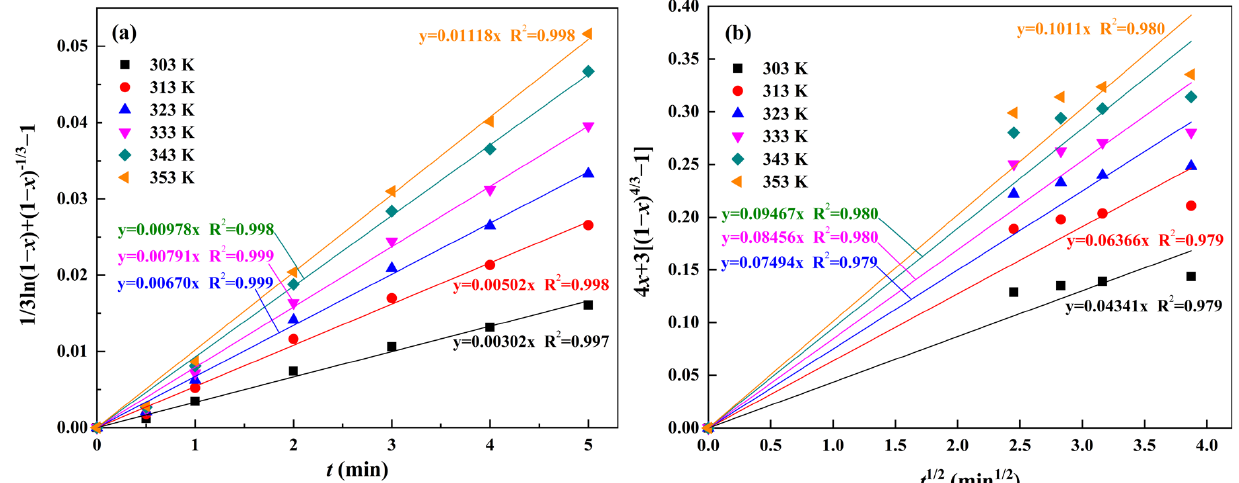
Figure 13. Fitting curves between experimental data and the calculated values with reaction rate